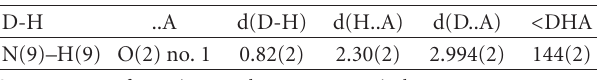
Table 6: Bond lengths [ ˚A] and angles [ ◦ ] related to the hydrogen bonding for [VO 2